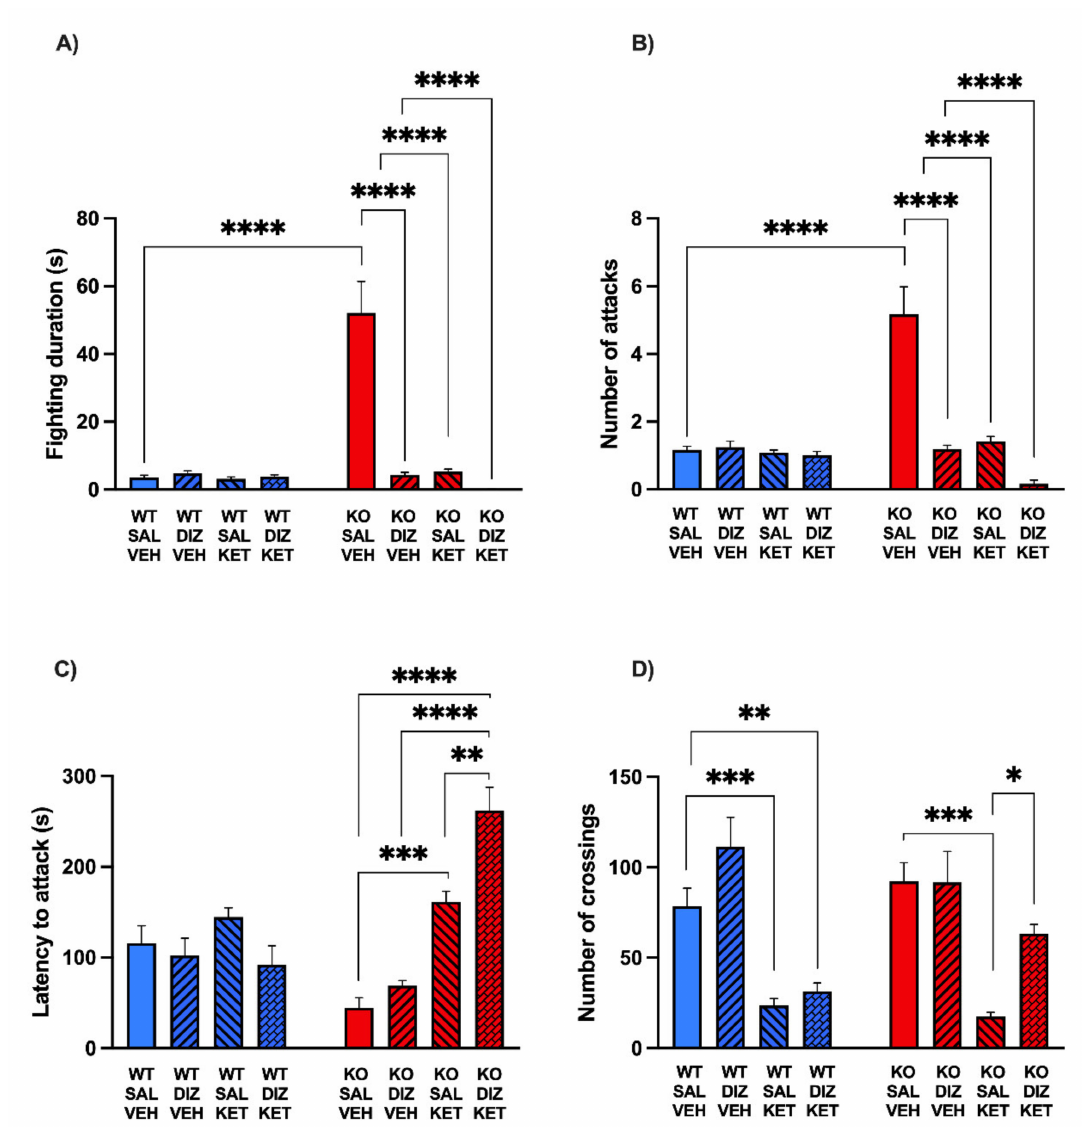
Figure 6. Impact of the systemic injection of ketanserin (KET, 2 mg/kg, IP) on the anti-aggressive effects of dizocilpine in MAOA KO mice. Data are shown as means ± SEM. Significance levels refer to the results of post hoc comparisons of three-way ANOVA analyses. ( A ): Overall duration of aggressive behavior; ( B ): Number of attacks; ( C ): The combination of DIZ and KET in MAOA KO mice had a significantly greater effect on latency than either drug; ( D ): motor activity within the same experiment revealed a significant three-way interaction. **** p < 0.0001, *** p < 0.001, ** p < 0.01, * p < 0.05 for comparisons indicated by bracket lines. (SAL, saline; VEH, vehicle; AU, arbitrary units); n = 11–12/group. Main effects are not indicated. For further details, see results